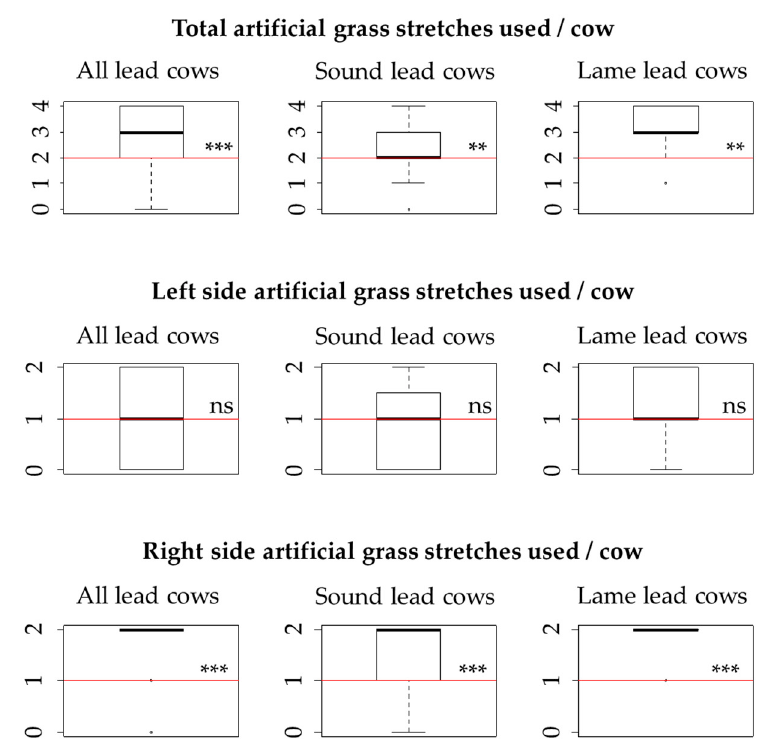
Figure 5. Median number of artificial grass stretches used by lead dairy cows compared to the number expected by chance (expected number displayed as a horizontal line filling the entire width of the frame). The total sample size was 66, including 43 sound lead cows and 19 lame lead cows. The maximum number of artificial grass stretches that could be used was four for the analysis including all stretches, and two for the analyses using either the left-side stretches or the right-side stretches. ** Significantly different from expected values, p < 0.001. *** Significantly different from expected values, p < 0.01. ns: No significant difference, p > 0.10.